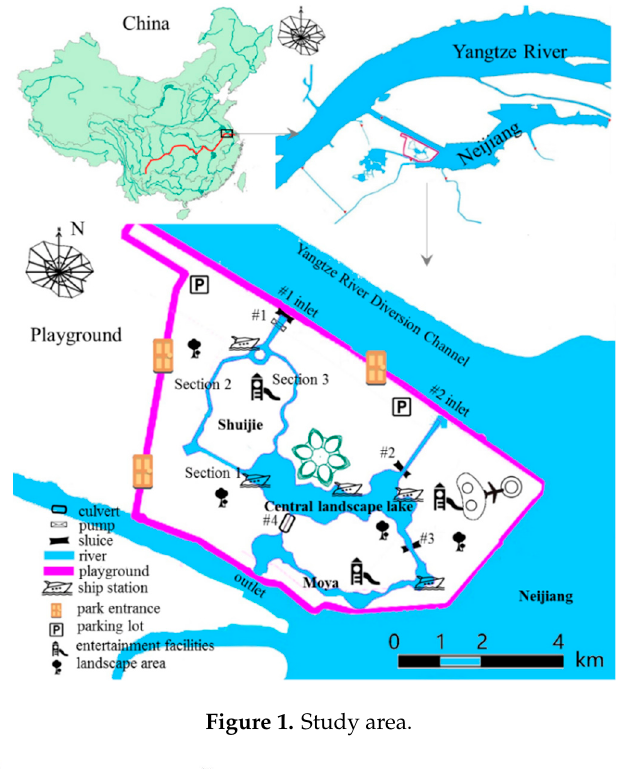
Figure 1. Study area.